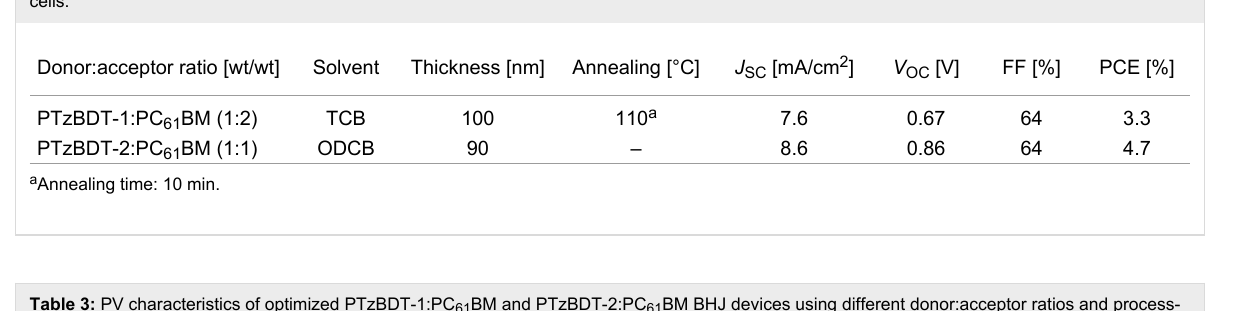
Table 3: PV characteristics of optimized PTzBDT-1:PC 61 BM and PTzBDT-2:PC 61 BM BHJ devices using different donor:acceptor ratios and process- ing conditions.